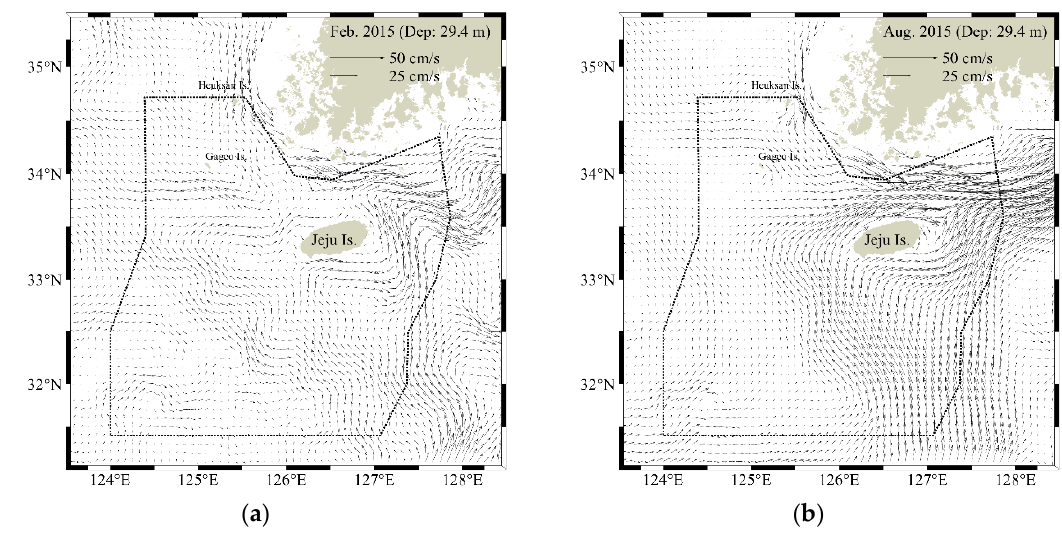
Figure 6. Global Ocean Physics Reanalysis GLORS12 model results: Current velocity in February ( a ) and August ( b ) in 2015 (the dotted line is the study area).